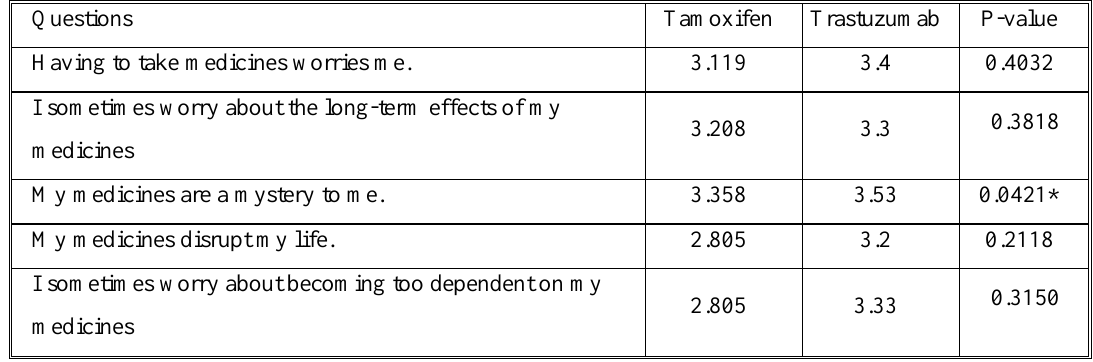
Table 3. Specific Concern (BMQ-SC) for both Tamoxifen and